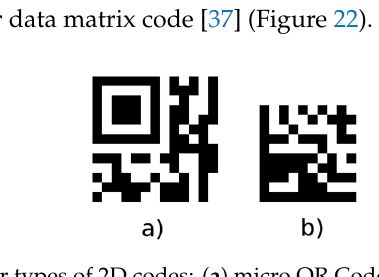
Figure 22. Other types of 2D codes: ( a ) micro QR Code; ( b ) data matrix code.